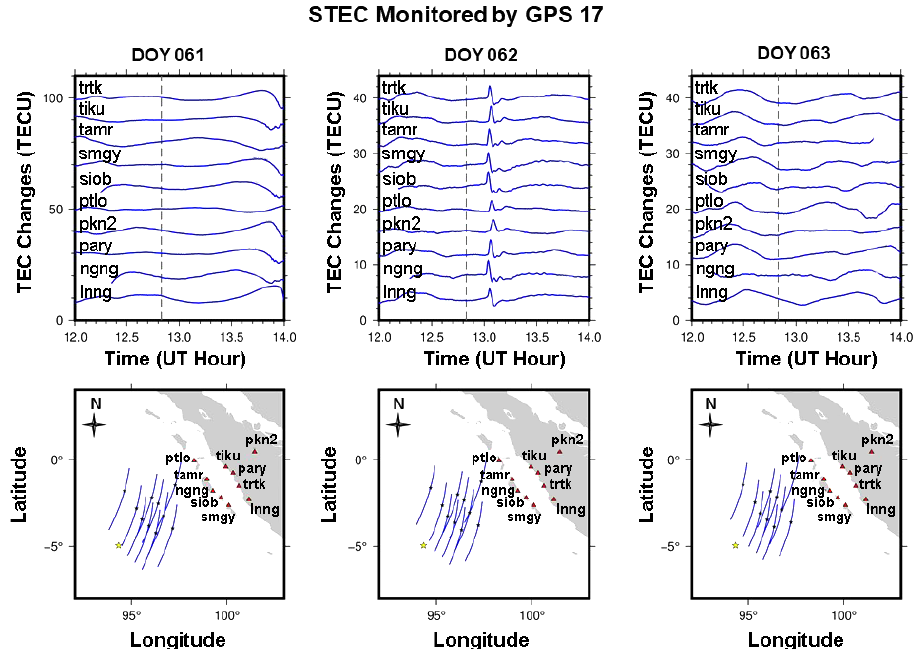
Figure A5. shows the slant changes of TEC in GPS PRN 17 one day prior to and one day after the earthquake in which the TEC changes occurred. The black vertical dashed lines in the time series indicate the time span of the 2016 Sumatra earthquake mainshock (12:49:48 UT). The small black stars indicate SIP on the trajectories during the mainshock event. The yellow stars indicate the epicenter, and the red triangle indicates GPS stations.